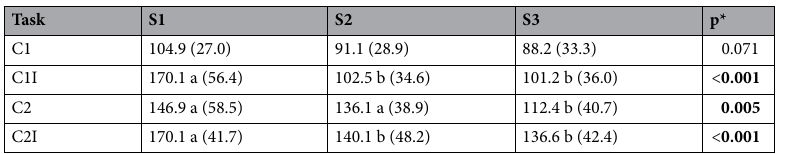
Table 1. Drill time (s) (presented as mean standard deviation) for the considered tasks, as a function of the consecutive experiment sessions (S1–S3). *RM ANOVA. statistically significant differences (p < 0.05) are denoted in bold. Different letters indicate significantly different means.